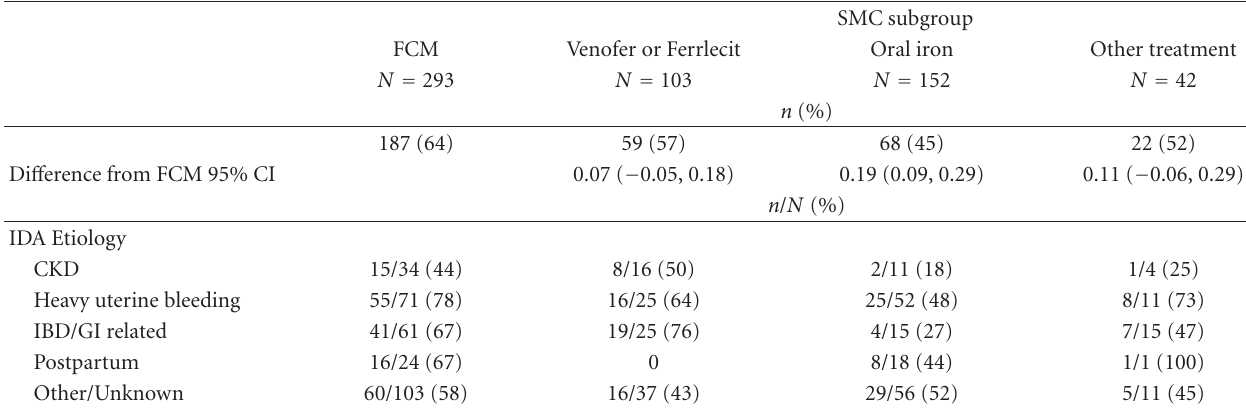
Table 3: Proportion of subjects in the multidose study with a clinically meaningful increase in hemoglobin anytime between baseline and the end of study or time of